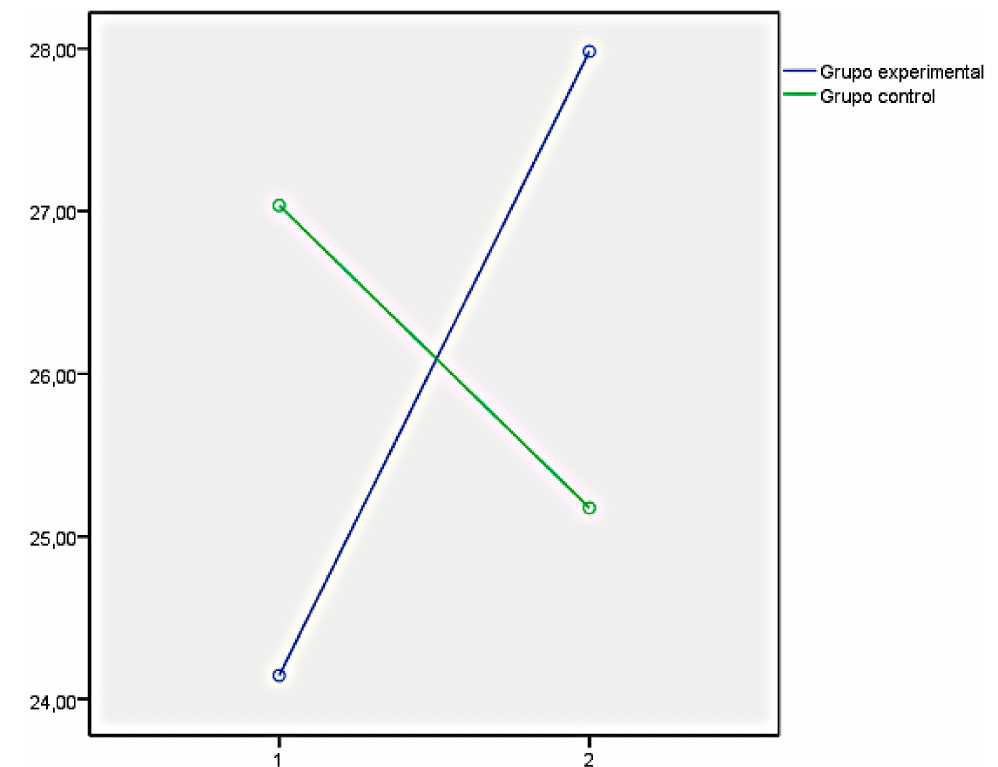
Figure 3. Clarity after the educational intervention measured with Trait Meta-Mood Scale.